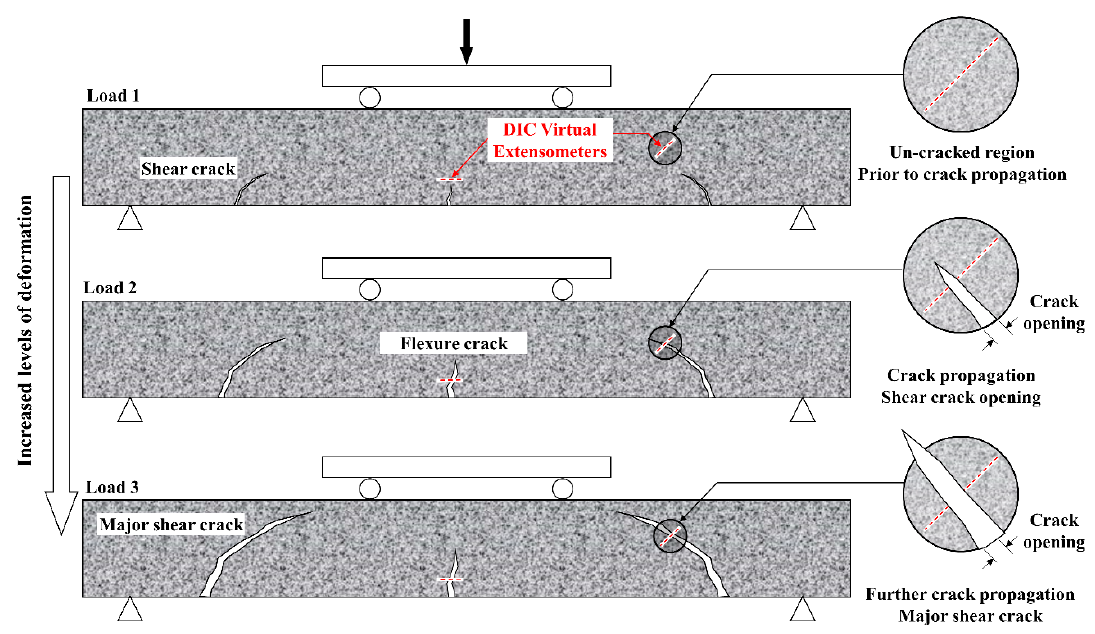
Figure 9. Schematic explaining the use of virtual extensometers for crack opening measurements.